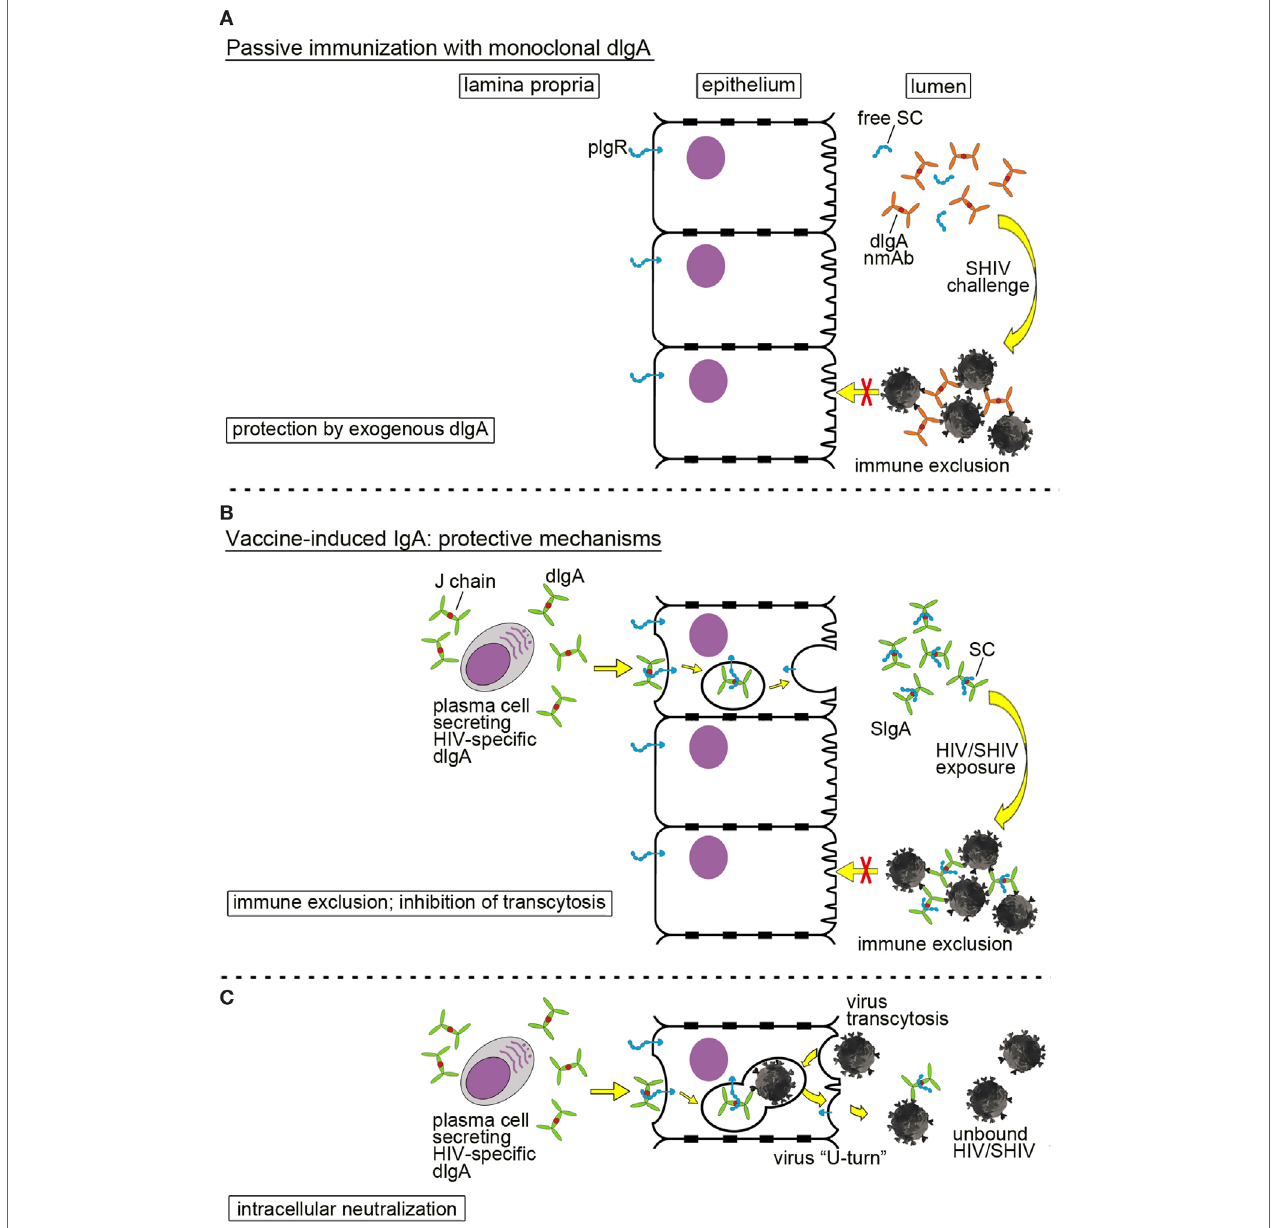
FiGURe 2 | Mucosal defenses by dimeric IgA (dIgA) or secretory IgA (SIgA) against HIV/simian-human immunodeficiency virus (SHIV). (A) Passive immunization with a neutralizing monoclonal anti-HIV Env dIgA. Topically administered neutralizing dIgA monoclonal antibodies prevent SHIV from crossing the epithelial barrier by formation of large immune complexes, leading to immune exclusion. To indicate the exogenous source and the recombinant nature of the monoclonal dIgA, the latter are colored in ochre in contrast to dIgAs produced locally by the host (green dIgAs; Figures 1A and 3B,C). (B,C) Mucosal SIgA induced by active immunization and different mechanisms of protection; (B) immune exclusion and inhibition of transcytosis. Plasma cells in the lamina propria produce virus-specific dIgA that interacts with the polymeric immunoglobulin receptor (pIgR; blue) on the basolateral surface of epithelial cells; pIgR transports dIgA across epithelial cells in transcytotic vesicles. Proteolytic cleavage of pIgR at the luminal side generates secretory component (SC) that is retained by dIgA molecules. The latter complexes are released as SIgA into the lumen. Virion invasion of epithelial cells is blocked by formation of large immune complexes between SIgA and SHIV leading to immune exclusion. (C) Intracellular neutralization. This phenomenon occurs when virions are taken up by epithelial cells and enter transcytotic vesicles, in which dIgA-pIgR cargo is being exported toward the lumen. Virions are bound by specific dIgA, and the entire virion-dIgA-pIgR complex is excreted. Essentially, the virion in the complex is forced into a U-turn. This figure has been adapted from the original review article “Are anti-HIV IgAs good guys or bad guys?” by Zhou and Ruprecht (10) (https://retrovirology.biomedcentral.com/articles/10.1186/s12977-014-0109-5). The original article is an open access article distributed under the terms of